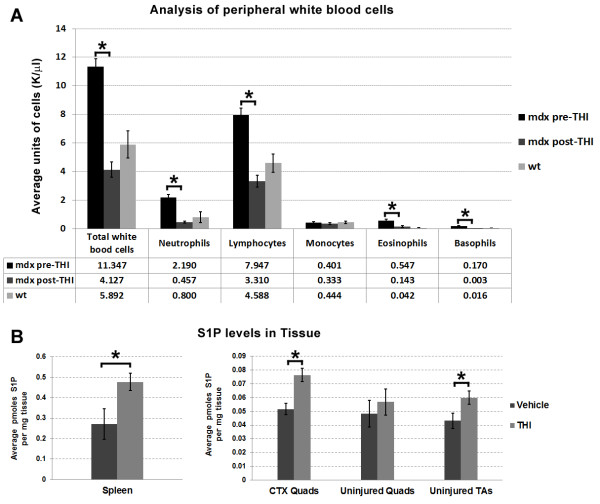
IP injection of THI reduces peripheral blood leukocytes and increases S1P levels in most tissues. (A) Leukocytes were analyzed from the peripheral blood of 1.5-MO mdx4cv mice (n = 3) before and 12 hours following treatment with THI (2 × 250 μl 0.15 mg/ml IP injections, 6 hours apart). IP administration of THI significantly reduced circulating leukocytes to values below or near age-matched wt (n = 4). The average value of each population is listed in the table below the bar graph. Values between pre and post THI, and wt were also significant by ANOVA (P <0.05) for all leukocytes except monocytes. (B)mdx4cv mice (n = 6, 5-MO) were treated with THI or vehicle for 3 days (2 × 250 μl 0.15 mg/ml IP injections per day) following CTX injury to assess changes in S1P muscle content. Muscles and spleens were harvested on day 4 post injury for S1P analysis by LC-MS/MS. Results indicate S1P levels in spleen and injured quadriceps (quads) were significantly elevated with THI treatment. Interestingly, uninjured quadriceps did not show a significant increase of S1P, whereas uninjured TA muscles did. *P <0.05 by student’s t-test. Error bars represent SEM. CTX, cardiotoxin; IP, intraperitoneal; LC-MS/MS, liquid chromatography-tandem mass spectrometry; MO, month-old; S1P, sphingosine-1-phoshate; SEM, standard error of the mean; TA, tibialis anterior; THI, 2-acetyl-4(5)-tetrahydroxybutyl imidazole; wt, wild type.